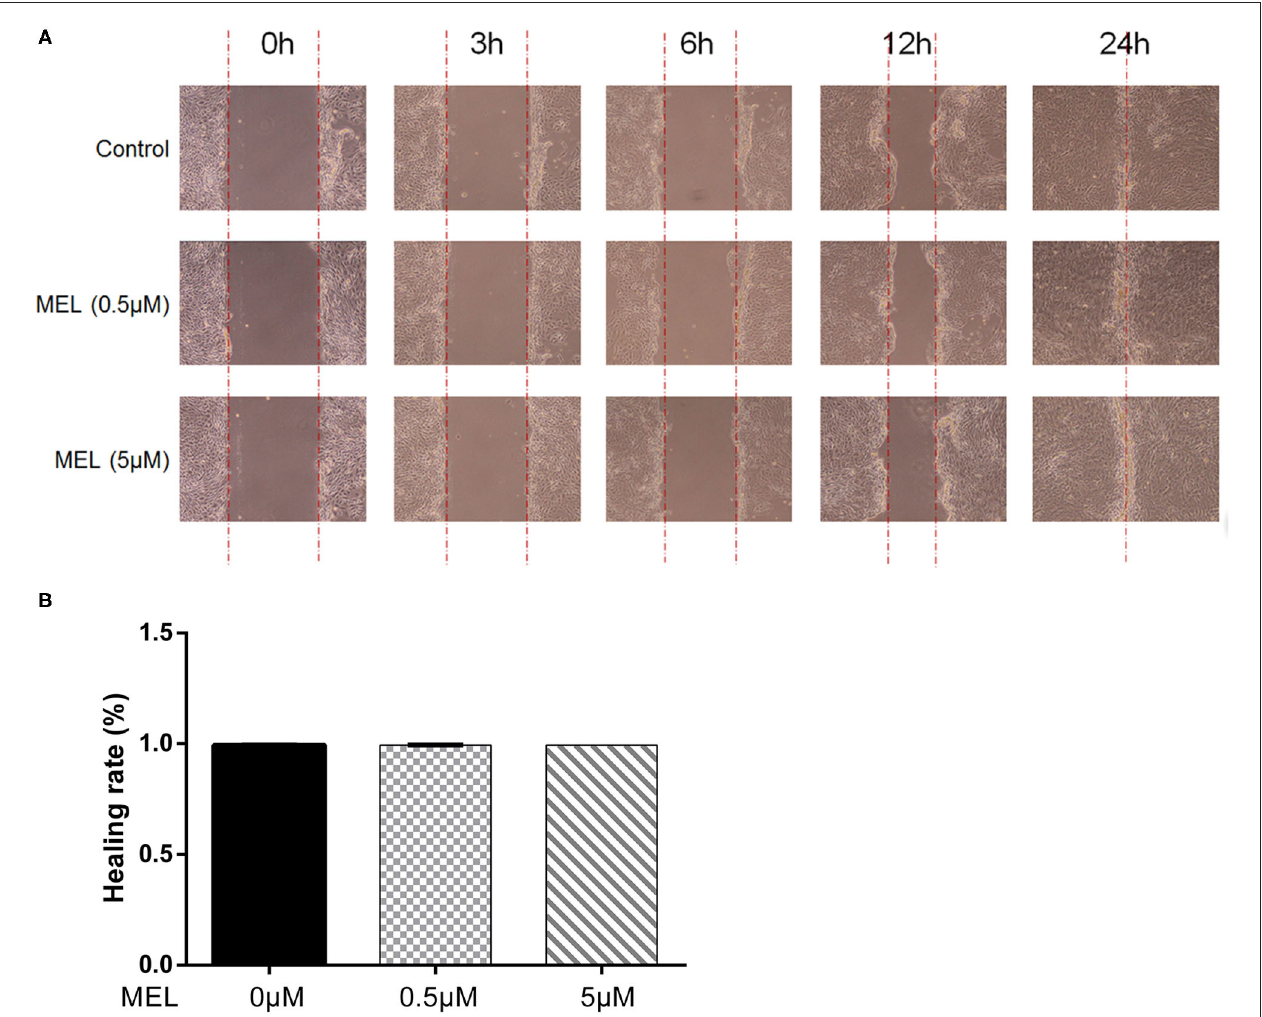
FIGURE 4 | The effect of meloxicam on the healing rate of bovine endometrial epithelial cells using the cell scratching test. MEL, meloxicam. (A) The cells were treated with 0.5 and 5 µ M MEL for 0, 3, 6, 12, and 24h to observe the cell healing under light microscopy at × 100 magnification. The parallel red dotted lines indicate the cell margins in the control group at each time point. (B) The healing rate of cells was detected at 24h using Image Pro Plus 6.0 software. Healing rate = (scratch width at 0h – scratch width at 24h)/scratch width at 0h × 100%. All data were presented as means ± SEM ( n =